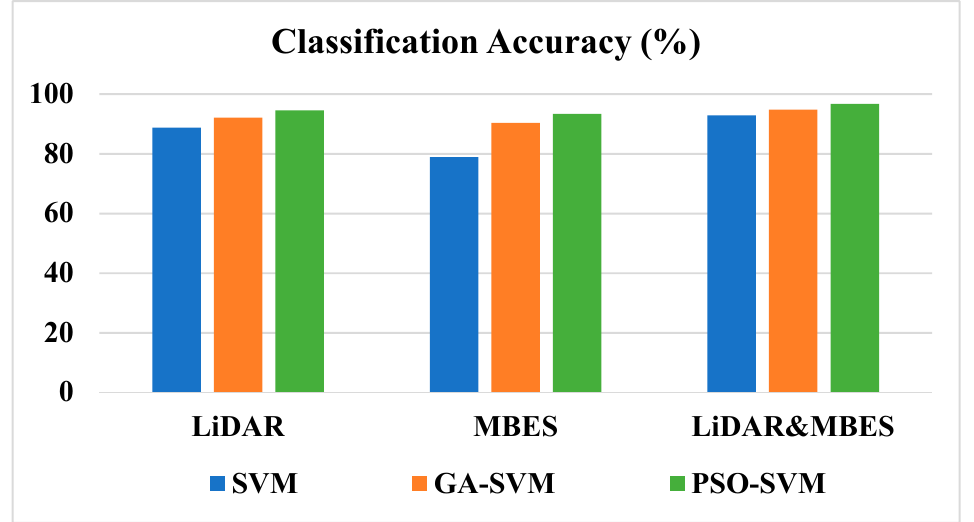
Figure 8. Statistics of the three combinations of classification accuracy. This is a comparison of the three algorithms (SVM, GA-SVM, PSO-SVM) before and after merging multifeatures. When classifying seafloor types based on LiDAR waveform features, the PSO-SVM classifier had the highest classification accuracy (up to 94.54%), and its kappa coefficient was 0.90. The SVM classifier had the lowest classification accuracy of 88.73% and a kappa coefficient of 0.80. Among the three types of seafloor, the classification accuracy of sands was relatively high. For the three classifiers, SVM, GA-SVM, and PSO-SVM, PA reached 96.86%, 97.31%, 97.82%, respectively. The classification accuracy of rocks was low. For SVM, GA-SVM, and PSO-SVM, PA was only 57.14%, PSO-SVM was better than that of both SVM and GA-SVM.